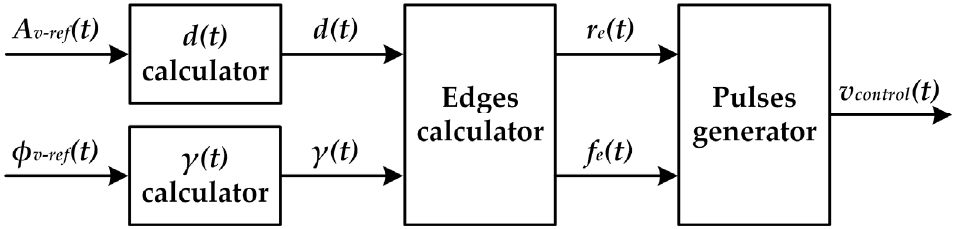
Figure 11. Blocks diagram of the control system used to implement the modulator of the RF-PWM Class D SMPA for VLC.